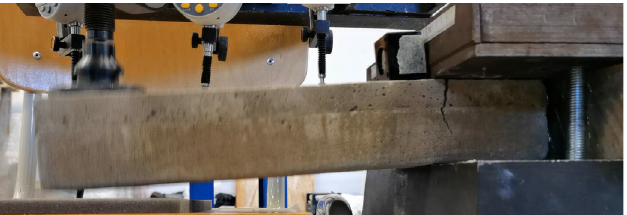
Figure 24. Collapse of specimen 19030420 after load test (composite FC and CC) without delamination.